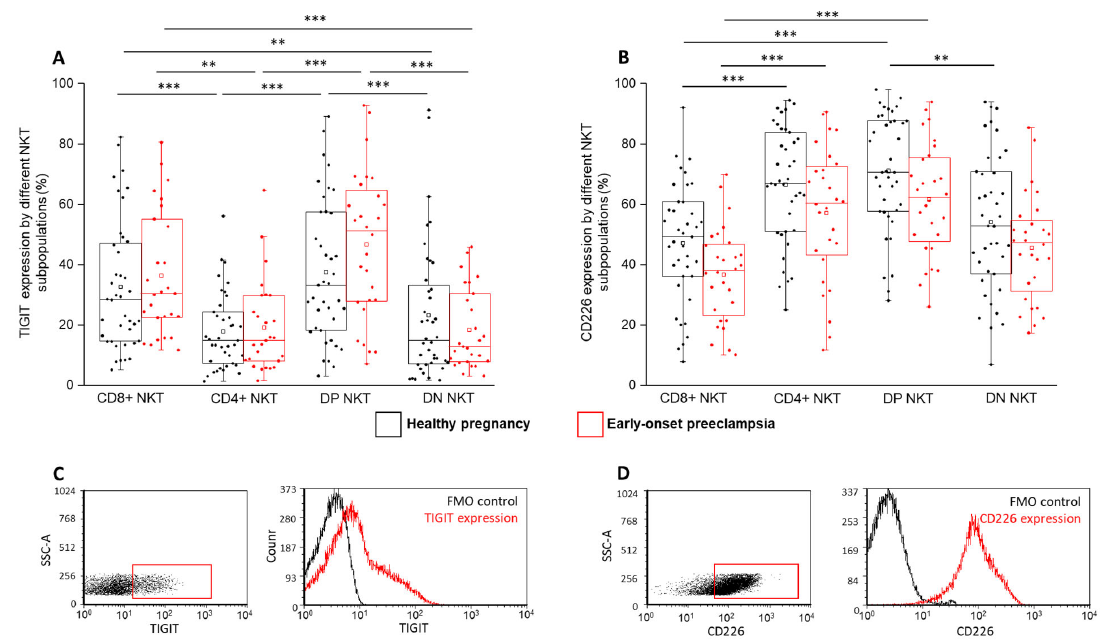
Figure 5. TIGIT and CD226 receptor expression by different NKT cell subpopulations in EOP and healthy pregnancy. TIGIT ( A ) and CD226 receptor expression ( B ) by the CD8 and CD4 surface mol ‐ ecule positive and negative NKT cell subpopulations in EOP patients and healthy pregnant women. The solid bars represent medians of 39, 40, 39 and 28 determinations, respectively. The boxes indi ‐ cate the interquartile ranges, and the whiskers show the most extreme observations. The middle square within the box represents the mean value. Significant differences with p ‐ values < 0.01 *** and <0.03 ** are indicated. Representative FACS plots show the TIGIT ( C ) and CD226 surface molecule ( D ) expression by cells in the lymphocyte gate. FMO control was used to determine TIGIT and CD226 expression.